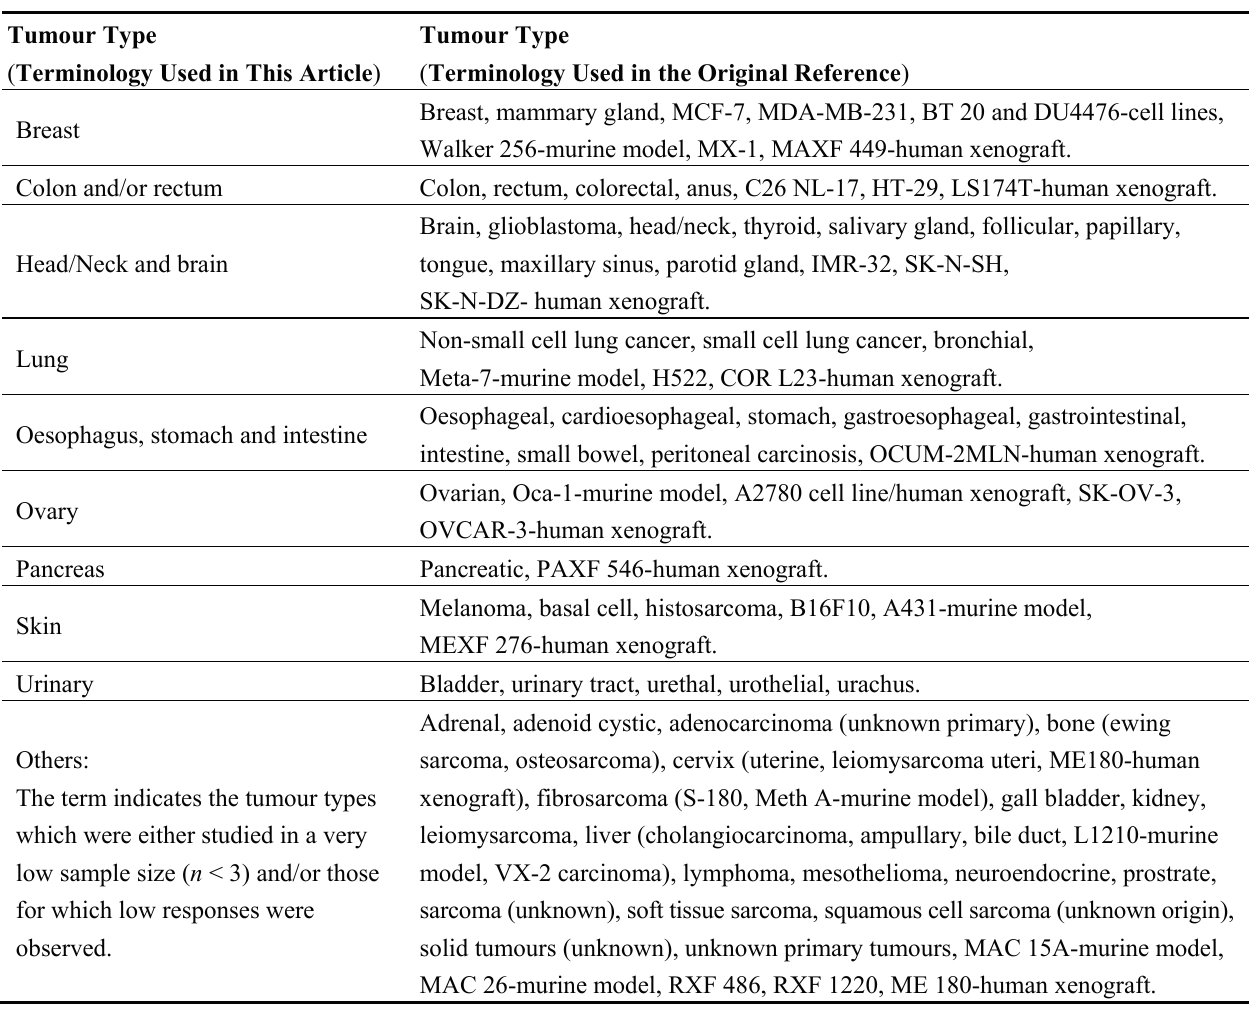
Table 2. Summary of the terminology used in this article to identify various tumour types/tumour